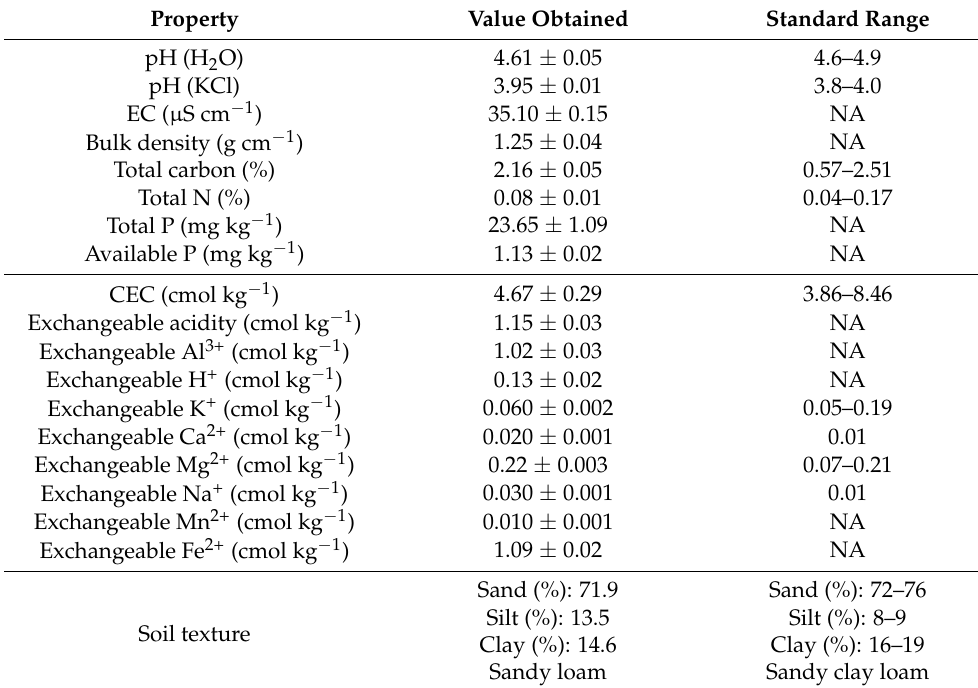
Table 1. Selected physico-chemical properties of the Bekenu Series (Typic Paleudults). Property Value